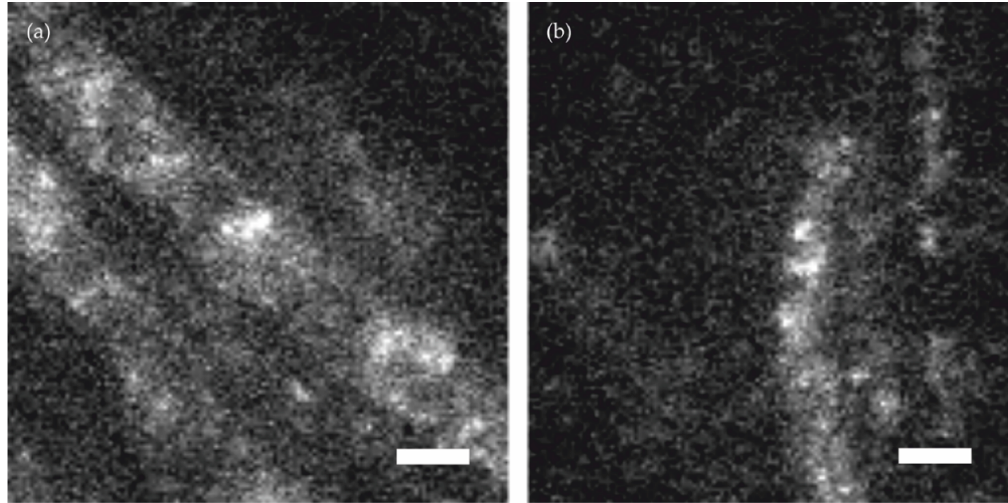
Figure 1. Representative images of Trichoderma atroviride hyphae recorded under identical imaging conditions. Panel ( a ) shows unstained wild-type, panel ( b ) an sfp2-mEGFP expressing strain labelled with an AF647 conjugated GFP-Trap. Scale bar = 3 µm.